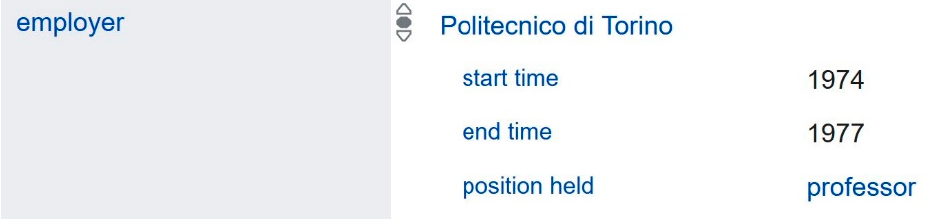
Figure 8. An example showing the use of qualifiers to represent additional information about a specific statement in Wikidata (from https://www.wikidata.org/wiki/Q286469, accessed on 10 May